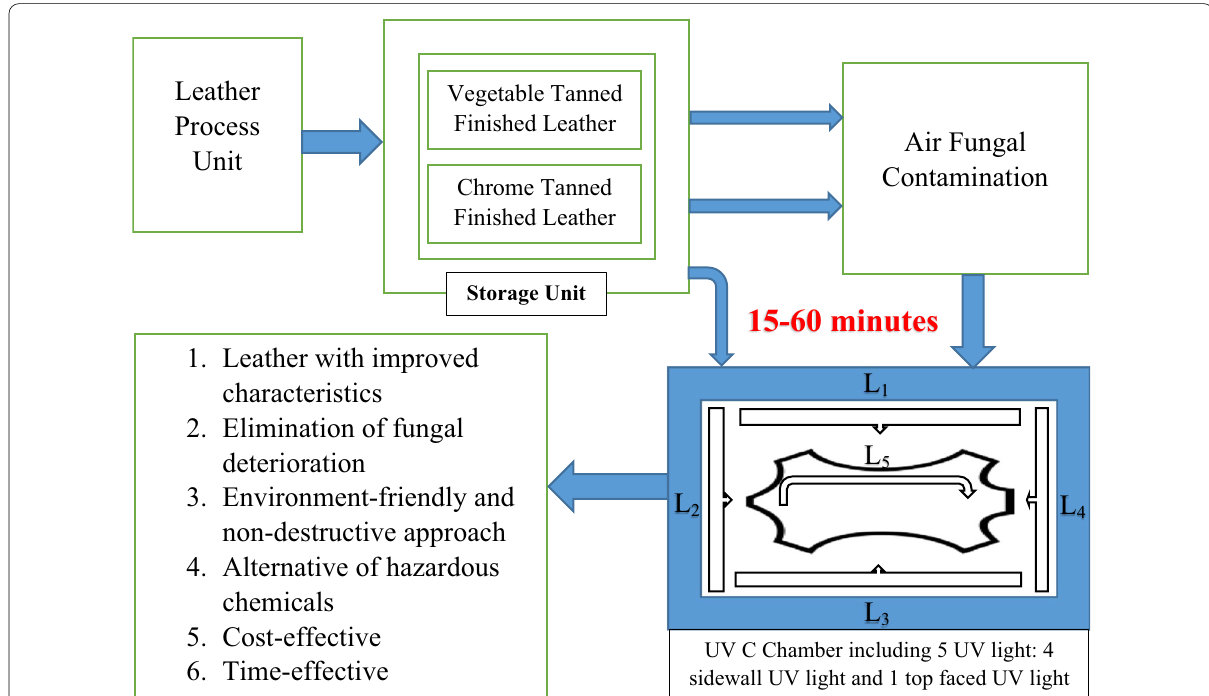
Fig. 7 Conceptual Model for UV-C irradiation of stored leather from prevention of fungal